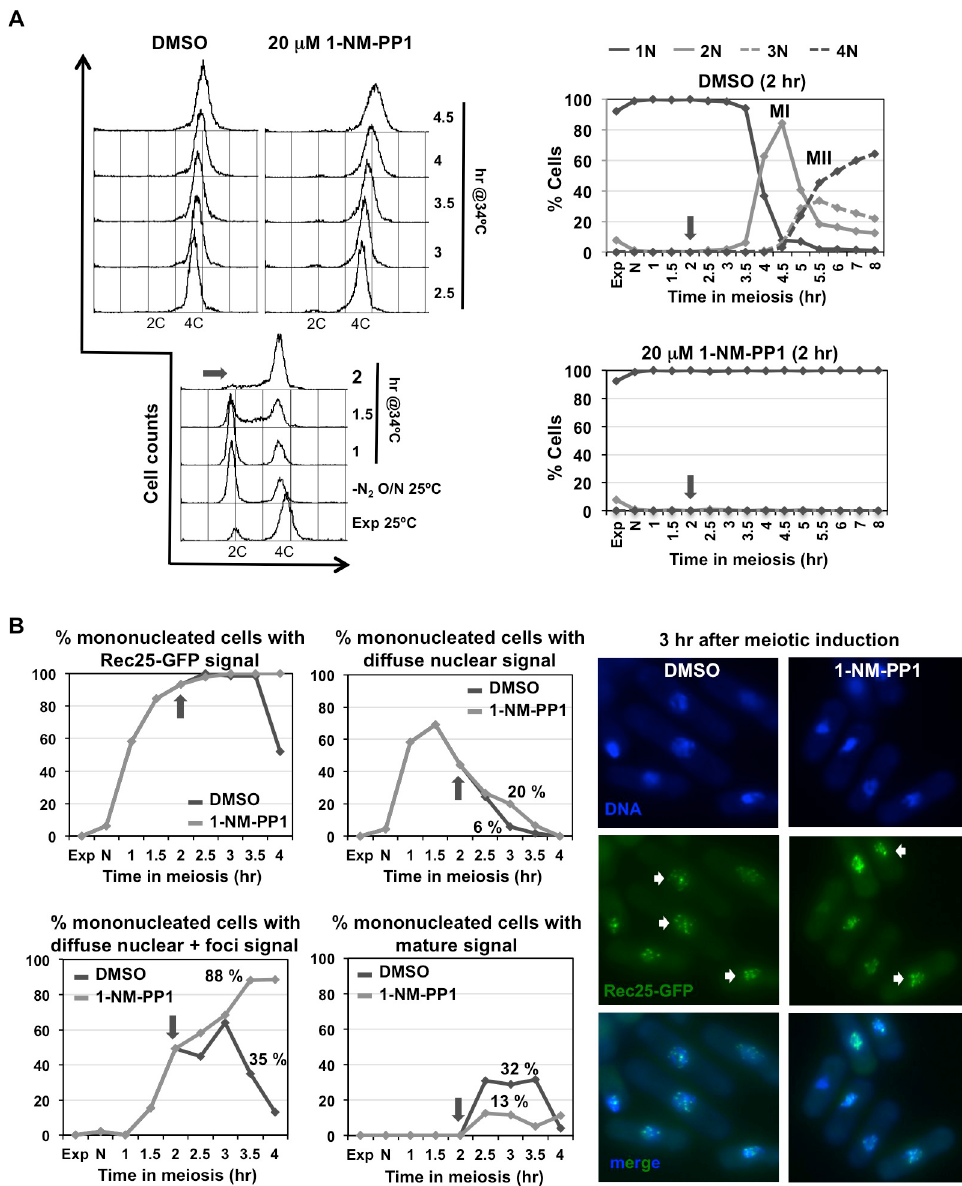
Fig 9. Chemical inhibition of Cdc2 impairs LinE maturation (CDK inhibition after DNA replication). (A) On the left Flow cytometry analysis of synchronous diploid pat1-114 cdc2-asM17 meiosis (CMC1192) with DMSO (top left panel) or 20 μ M 1-NM-PP1 (top right panel) added at 2 hr (arrow in the bottom panel) after meiotic induction of a common culture. DNA content (FL2-H) histograms are shown. On the right Quantification of chromosome segregation by DAPI staining and nuclear counting (1 nucleus, 2 nuclei, 3 nuclei, and 4 nuclei) is shown. Timing of meiosis I (MI) and meiosis II (MII) is indicated. Arrows indicate time of DMSO or 1-NM-PP1 addition. (B) On the left Quantification of LinE formation by visualization of Rec25-GFP maturation status during the same meiotic kinetics. Graphs represent the percentage of mono-nucleated cells with Rec25-GFP signal (any category), diffuse nuclear signal (earliest transient category visible at S-phase), diffuse nuclear + foci signal (later transient category visible at prophase), and mature signal (clear foci; latest category visible at late prophase). Arrows indicate time (2 hr) of DMSO or ATP-analog addition. Right panel Photographs of cells in prophase (Methanol/Acetone fixed) at 3 hr after meiotic induction when maximal maturation of LinEs is observed in the control. DNA (DAPI-staining; top panels), Rec25-GFP signal (middle panels), and both (merge; bottom panels). Arrows indicate cells with Rec25-GFP mature signal; notice the heterogeneity of Rec25-GFP categories in 1-NM-PP1 treated cells. At least 36 cells were analyzed at each time point from 1 hr after meiotic induction (when signal first appeared), increasing the number of cells to 60–93 during prophase. Similar result (defective LinE maturation) was obtained in an independent experiment.